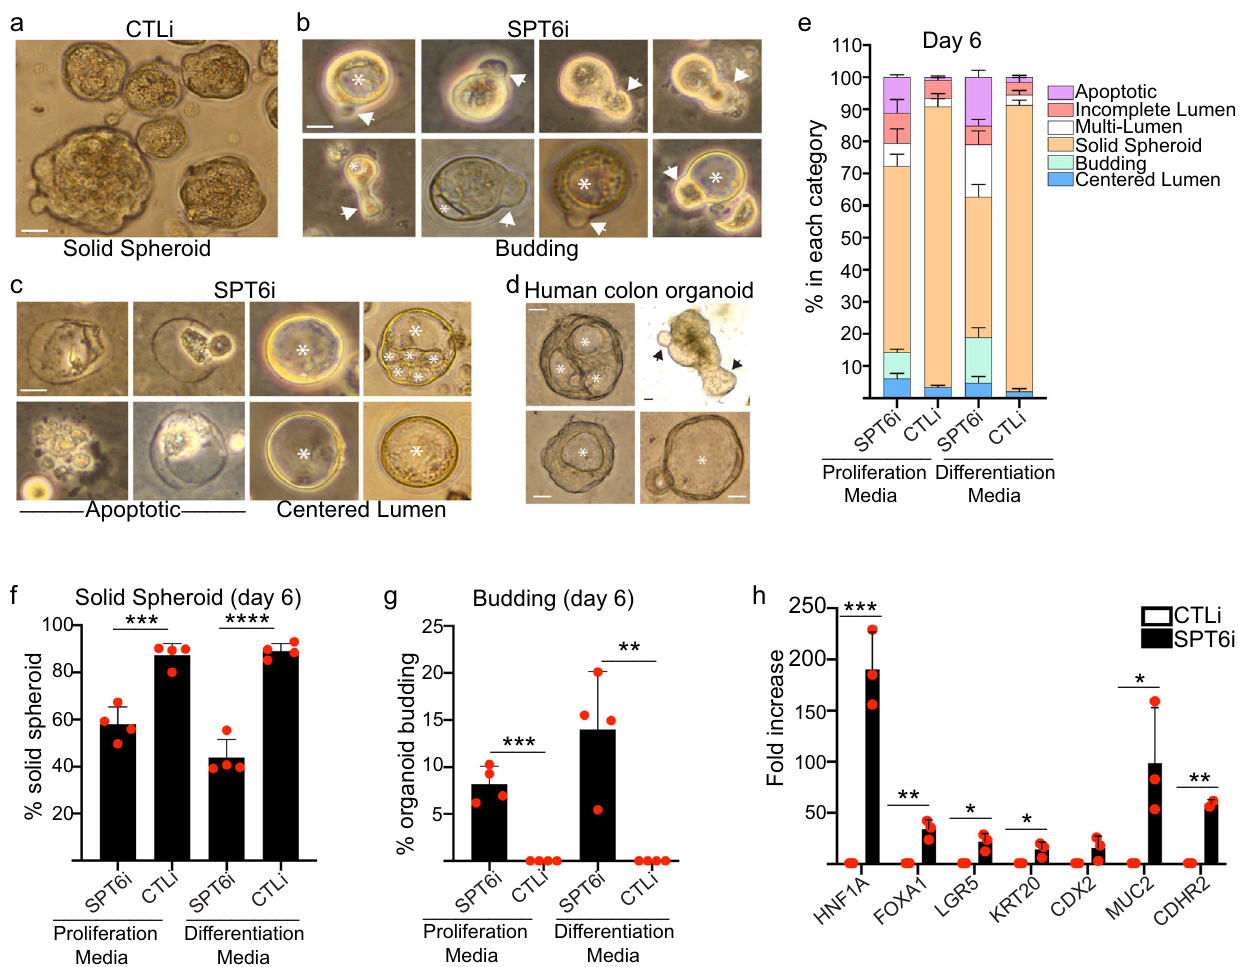
Fig. 7 SPT6 knockdown cells can generate structures resembling intestinal organoids. a Representative image of control (CTLi) knockdown primary human keratinocytes grown in matrigel in the presence of Wnt3a, R-spondin, and noggin. b , c Images of SPT6 (SPT6i) knockdown primary human keratinocytes grown in matrigel in the presence of Wnt3a, R-spondin, and noggin. A montage of images of budding organoids is shown in b . A montage of images of apoptotic ( c : left panel) and lumen-containing spheroids ( c : right panel) is shown. d Representative images of healthy human colon organoids are shown. Arrows denote budding and asterisks denote centered lumen for b – d . Scale bar = 100 μ m for a – d . N = 4 independent experiments which all showed similar results. e Stacked bar graphs display the percent (%) of SPT6 (SPT6i) or control (CTLi) knockdown organoids that are budding, apoptotic, with incomplete lumen, multi-lumen, solid spheroids, or centered lumen. N = 4 independent experiments. f Bar graphs display the percent (%) of SPT6i or CTLi solid spheroids. N = 4 independent experiments. *** = 0.0006 for proliferation media. g Bar graphs display the percent (%) of SPT6i or CTLi organoids that are budding. N = 4 independent experiments. *** = 0.0001 for proliferation media, ** = 0.0039 for differentiation media. h RT-qPCR quantifying the relative mRNA expression levels of intestinal genes in CTLi and SPT6i organoids. qPCR values were normalized to L32 . *** = 0.0009 for HNF1A, ** = 0.0037 for FOXA1, * = 0.012 for LGR5, * = 0.0332 for KRT20, * = 0.036 for MUC2. N = 3 independent experiments. Mean values are shown with error bars = SD. * p < 0.05, ** p < 0.01, *** p < 0.001, **** p < 0.0001 (two-sided t -test, f – h